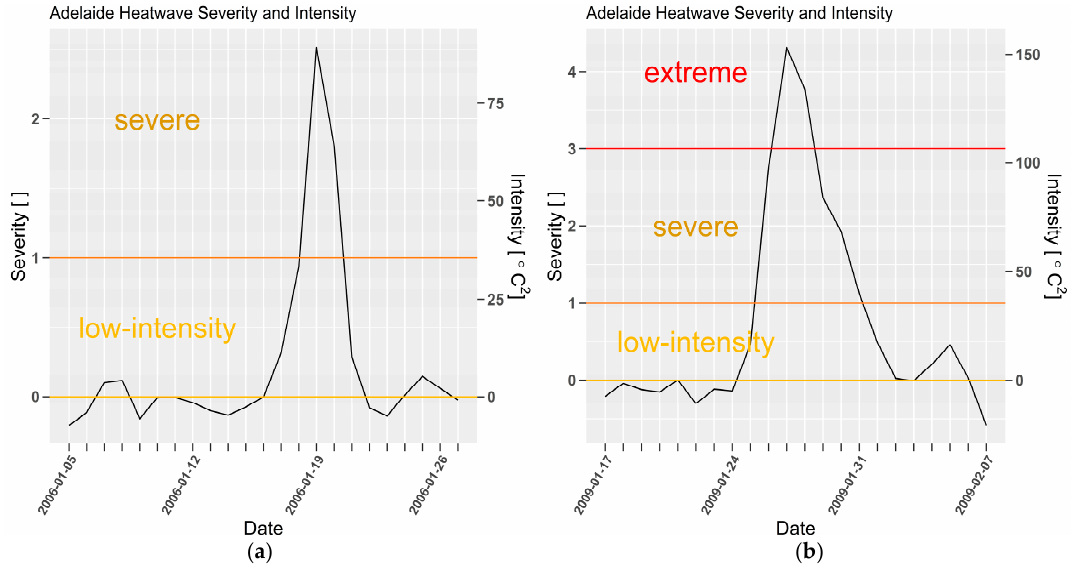
Figure A8. Excess Heat Factor for Adelaide’s 2006 ( a ) and 2009 ( b ) heatwaves, calculated using site data. Dimensionless heatwave severity [] and intensity (EHF, [°C 2 ]) on left and right y -axes respectively.